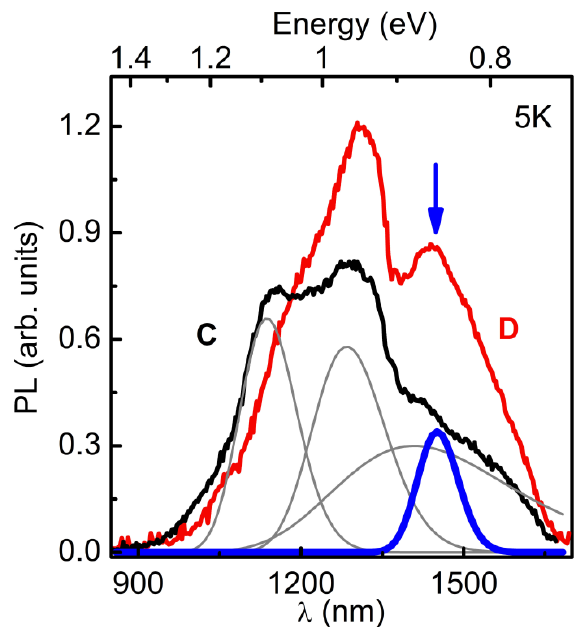
Figure 6. Steady-state low-temperature (5 K) PL spectra measured under the nonresonant excitation in an AlP matrix at P ex = 25 W/cm 2 for the GaSb/AlP SAQD HS D (red line) and HS C without SAQDs (black line). Thin gray lines show a set of Gaussians with the maxima at the energies of 0.88, 0.96, and 1.09 eV used to fit the spectrum of HS C . In the PL spectrum of HS D , an additional PL band appears with a maximum at 0.86 eV, as shown by a thick blue line and by a blue arrow. As it is presented in Figure 6, the spectrum of HS C without SAQD consists of bands whose shape is well described by Gaussian functions with the maxima at the energies of 0.88, 0.96, and 1.09 eV, with the full width at half maximum (FWHM) values of 230, 120, and 110 meV, respectively. We attribute these PL bands to the charge carrier recombination through deep levels in the AlP and/or GaP layers. A detailed elucidation of the nature of these deep levels is beyond the scope of this work. The spectrum of SAQD HS D contains PL bands, whose shape is also described by the Gaussian function, and their spectral position, the FWHM and amplitude values are close to the corresponding bands in the spectrum of the HS C without SAQDs. The bands are characterized by the maxima at energies of 0.88, 0.95, and 1.08 eV, with FWHM values of 230, 112, and 120 meV, respectively. The change in the PL band intensity compared to the spectrum of the HS without SAQDs is no more than 30%. We also attribute these PL bands to the recombination through deep levels in the bulk material. Furthermore, the spectrum contains an additional PL band with a maximum at 0.86 eV and an FWHM value of 72 meV, which is marked in Figure 6 with a thick blue line. We attribute this additional band to the charge carrier recombination in the SAQDs. As can be seen, the PL data obtained at 5 K are in good agreement with the PL data obtained at 77 K (Figure